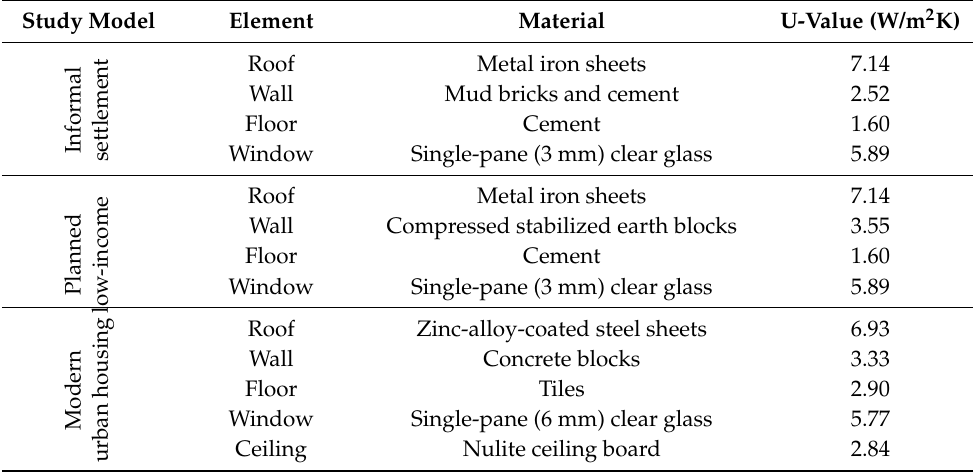
Table 1. Thermal properties of the study